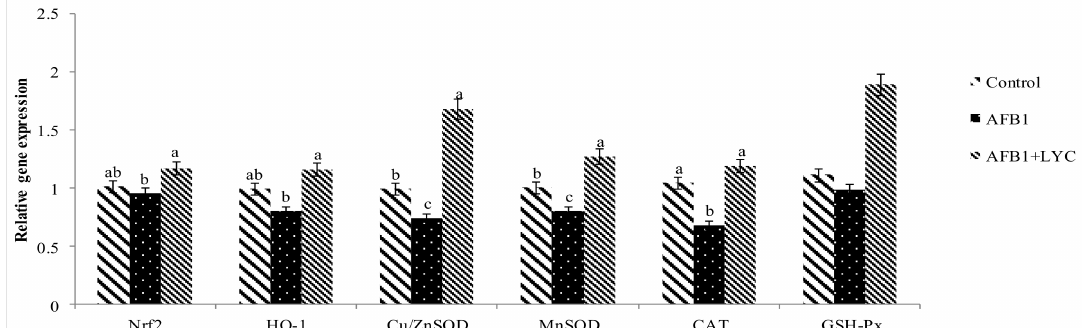
Figure 3. Effects of LYC on antioxidant gene expression in the jejunum of broiler intestine fed AFB 1 contaminated diet. The column and its bar represented the means and standard error of the means ( n = 6), respectively. abc Means with different superscript letters are significantly different ( p < 0.05). Nrf2, nuclear factor-erythroid2-related factor2; HO-1, heme oxygenase-1; Cu/ZnSOD copper and zinc superoxide dismutase; MnSOD, Manganese superoxide dismutase; CAT, catalase; GSH-Px, glutathione peroxidase; AFB 1 , AflatoxinB 1 ; LYC, Lycopene; and AFB 1 + LYC, (100 µ g/kg AFB 1 + 200 mg/kg